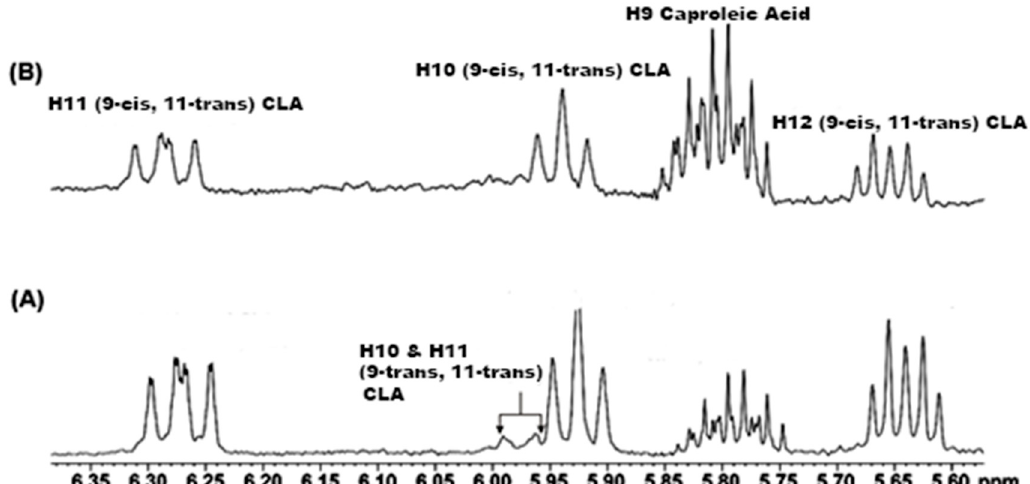
Figure 5. Selected region of 500 MHz 1 H-NMR spectra of the lipid fraction of lyophilized organic ( A ) and conventional ( B ) bovine milk samples in CDCl 3 (T, 298 K; number of scans, 256; acquisition time 4.3 s; relaxation delay, 5 s; total experimental time ~45 min). Some characteristic resonances from CLA and caproleic fatty acids are indicated.